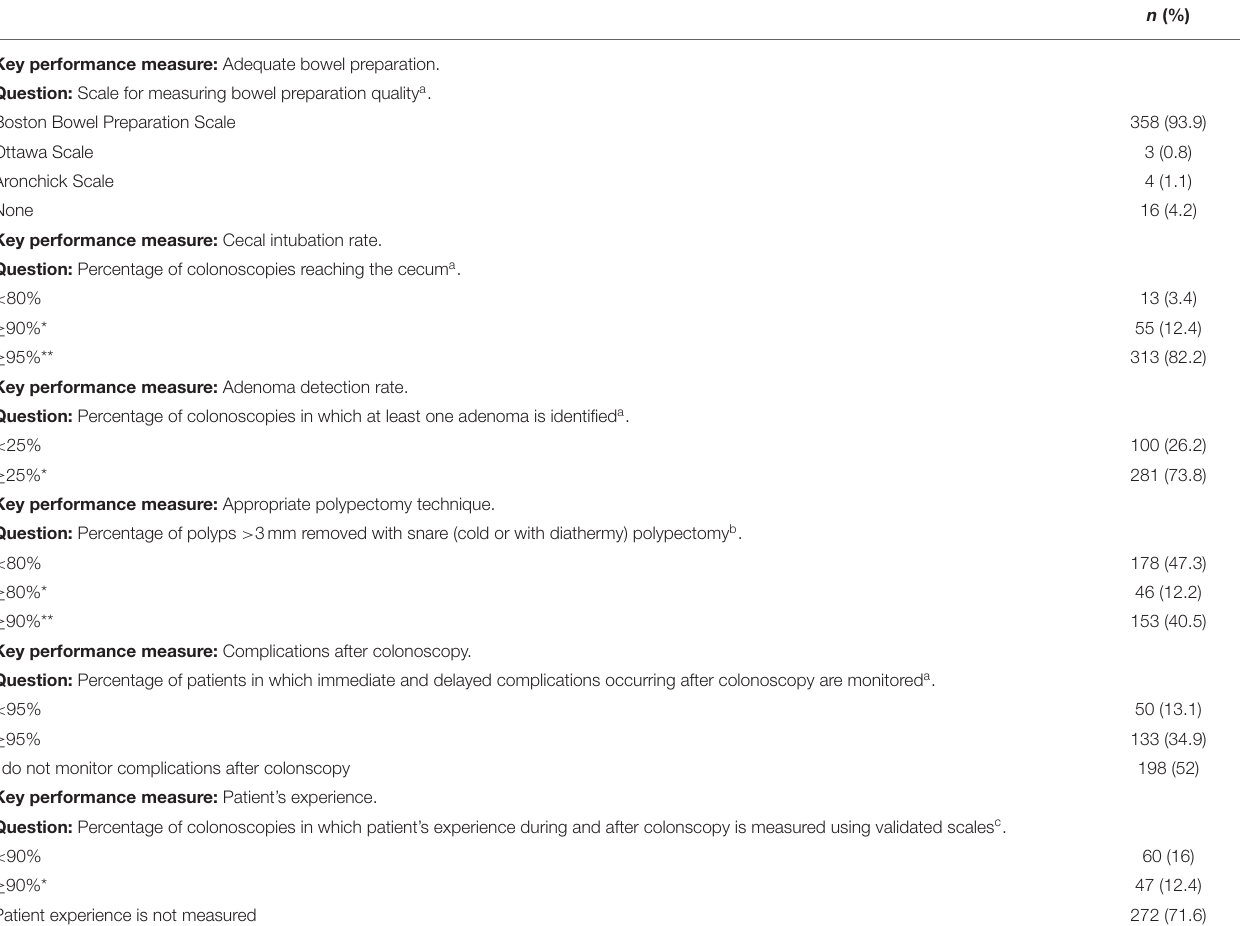
a Missing data for 11 participants. b Missing data for 15 participants. c Missing data for 12